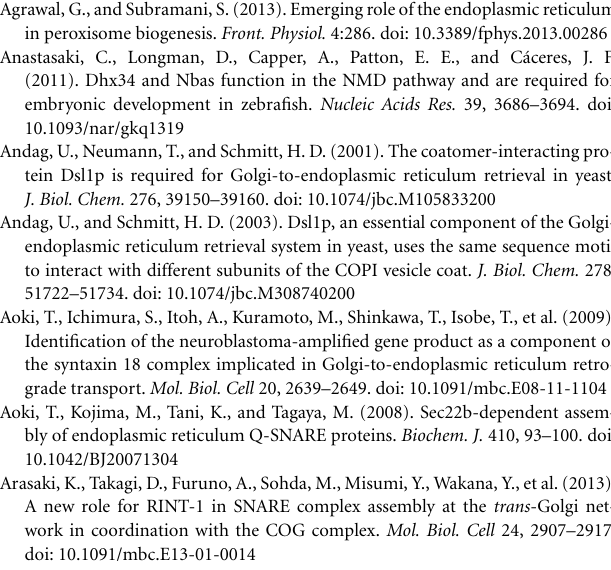
2010). On the other hand, RINT1 interacts with COG1 through its N-terminal, putative coiled-coil region (Arasaki et al., 2013). This interaction mode may be a common for the interactions of CATCHR family members. The N-terminal region is also responsible for the interaction with UVRAG, but in this case, RINT1 keeps the binding to ZW10 (He et al., 2013). The RINT1 interacts with RAD50 and RBL2/p130. UVRAG interacts with RINT1 under basal conditions and, upon starvation, dissociates from RINT1 and interacts with Beclin1. Of note is that Beclin1 during mitosis interacts with ZWINT, a ZW10